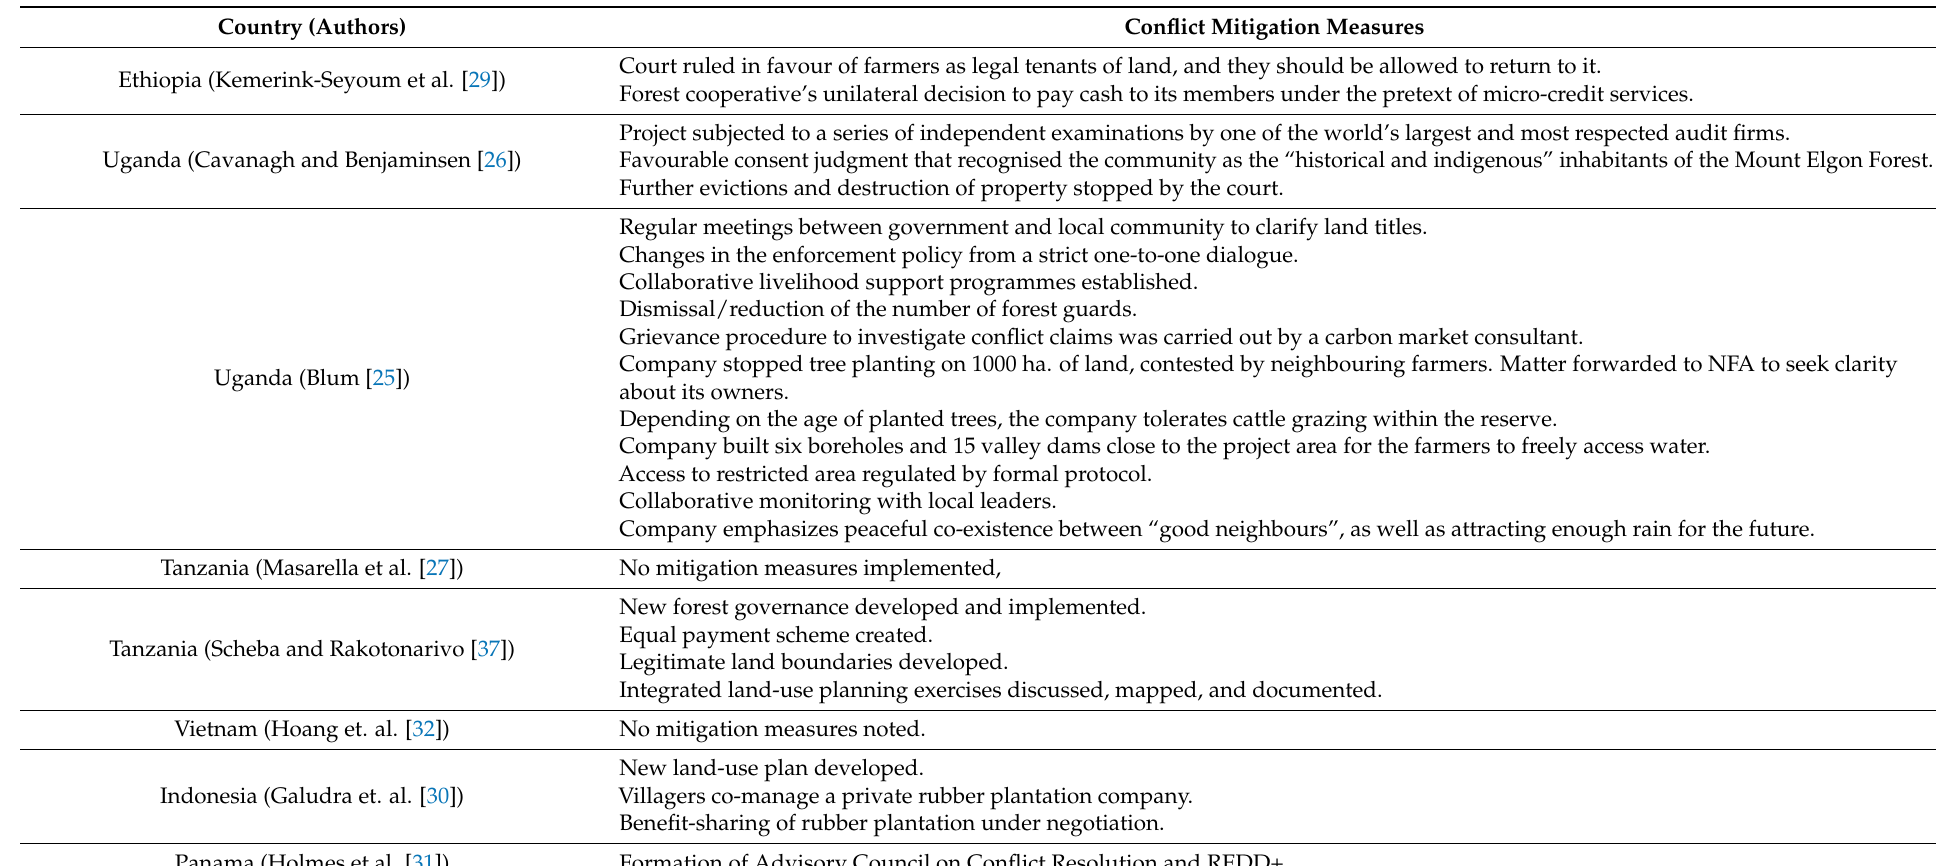
Table 3. Conflict mitigation